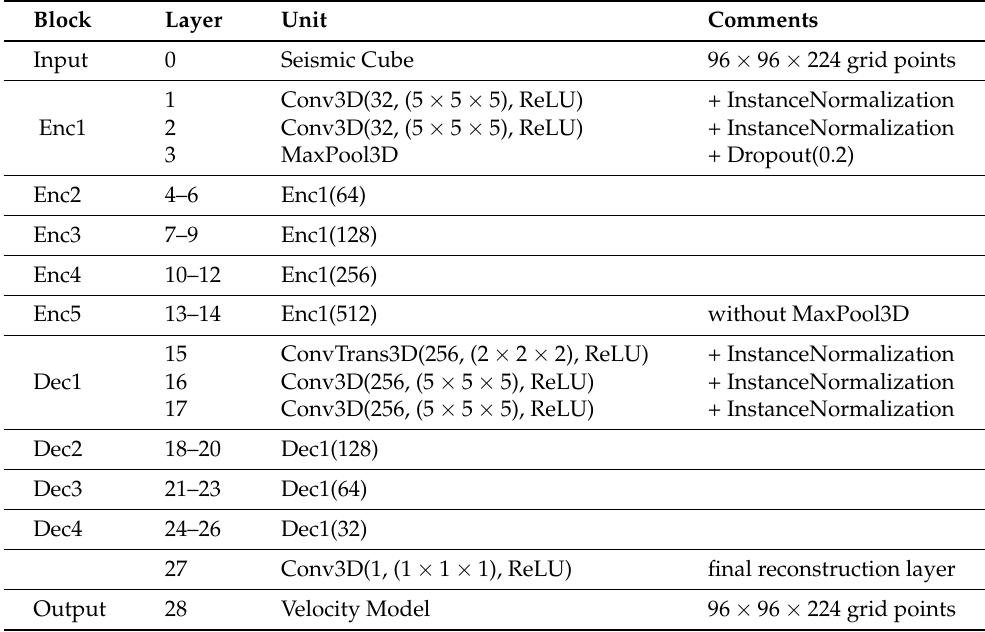
Figure 1. The proposed 3D Encode-Decoder architecture, based on the U-Net architecture. The skip connections perform a replication of the encoder feature maps, which are further concatenated with the corresponding decoder feature maps. Additional details are provided in Table 1. Table 1. Proposed encoder–decoder